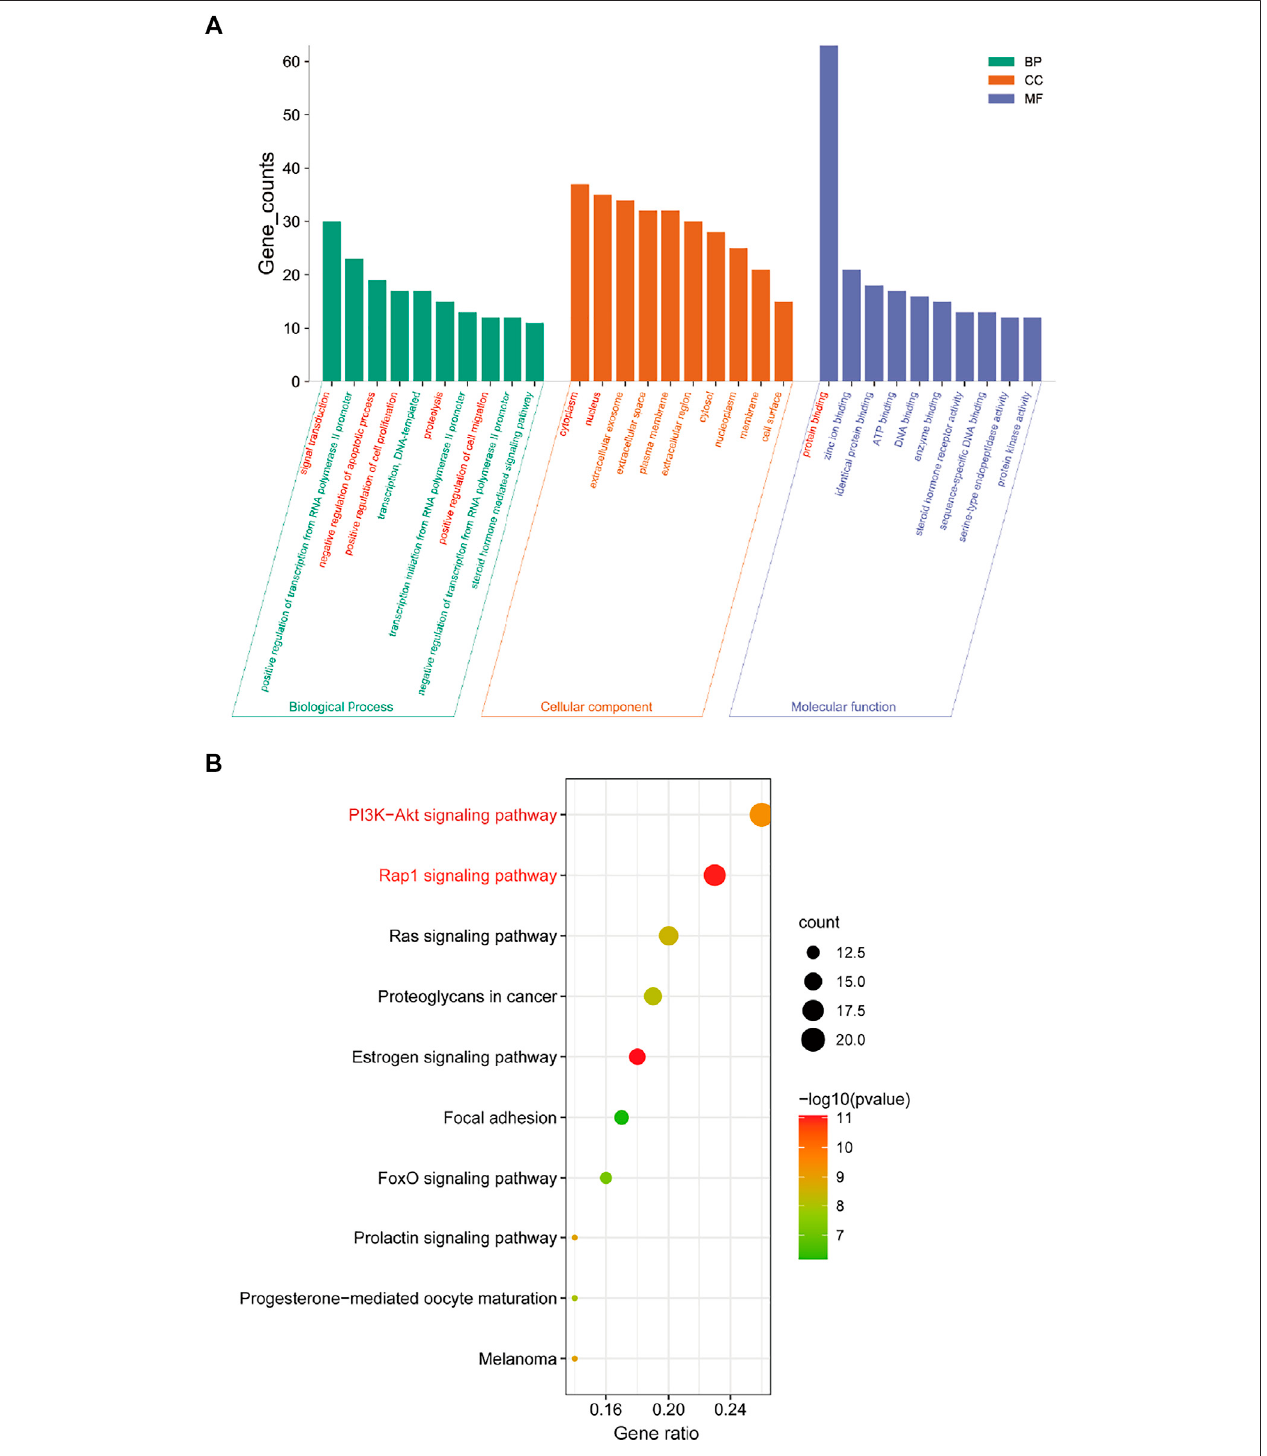
FIGURE 5 | Enrichment analysis for key targets. (A) The GO enrichment analysis of key targets. BP means biological processes, CC means cell component, MF means molecular function. (B) The KEGG pathway analysis of key targets. Nodes size and color depth are proportional to the gene ratio involved in the